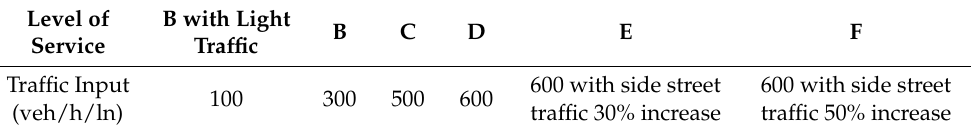
Table 3. Traffic input scenarios.